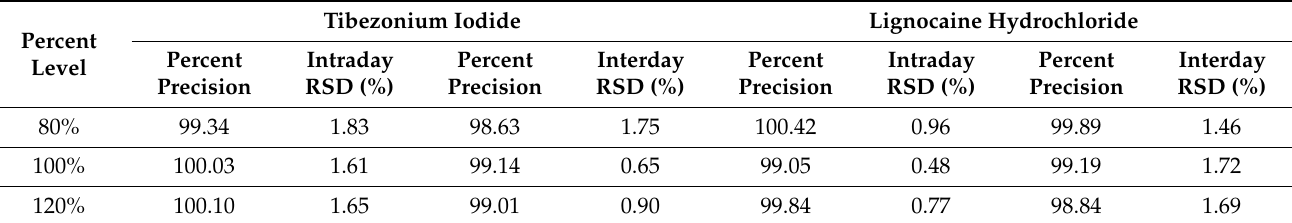
Table 3. Response of drugs indicating precision of the devised